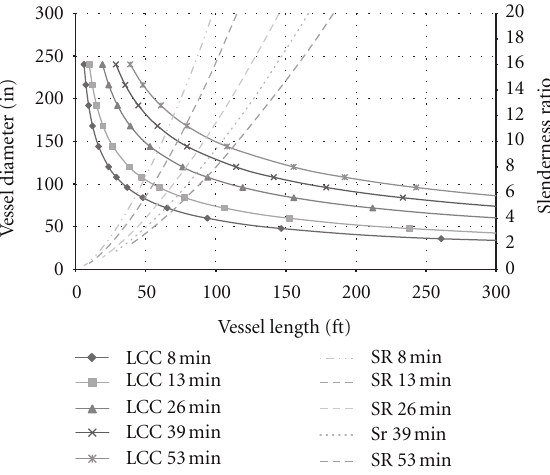
Figure 7: Modified Arnold-Stewart’s method using peak emulsion